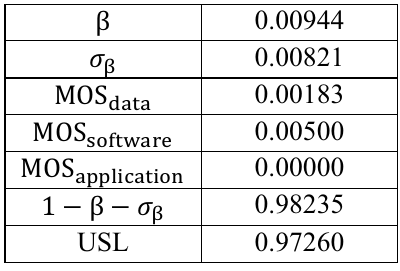
Table III. Summary of Upper-Subcritical-Limit Obtained by